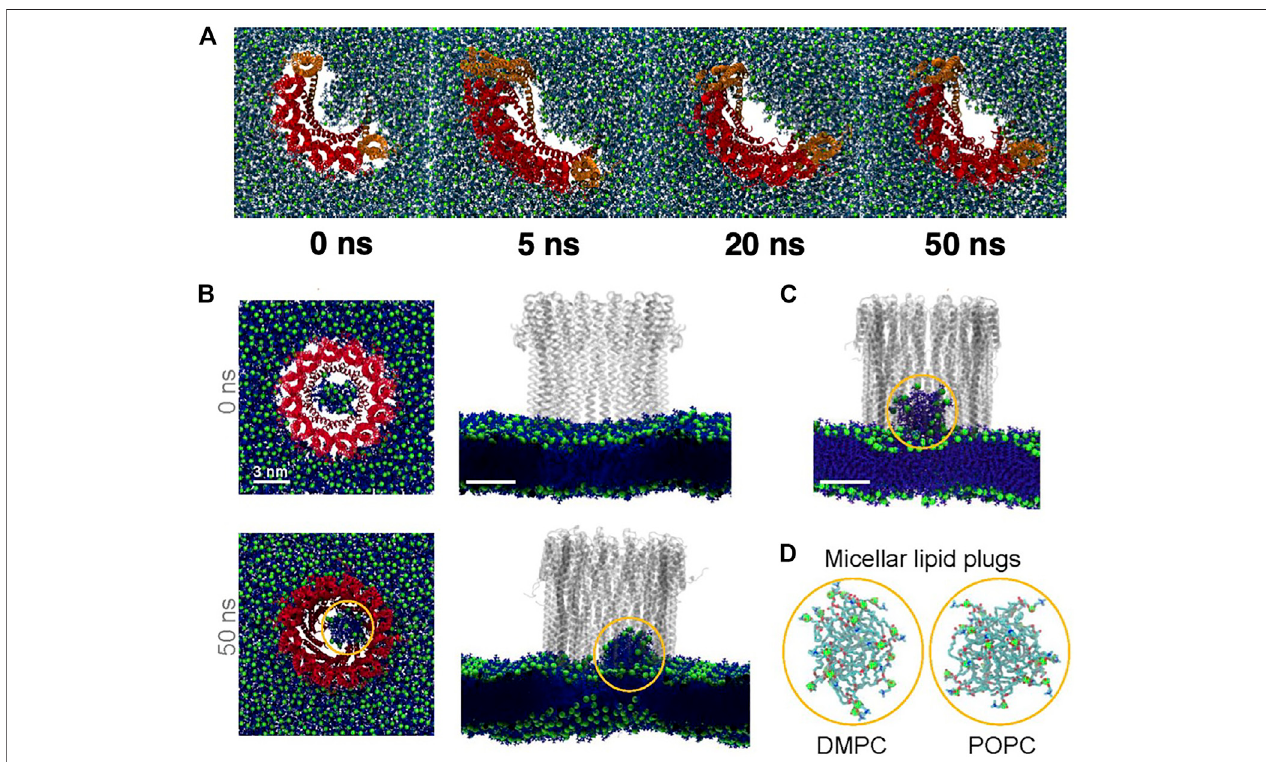
FIGURE 13 | Snapshots from all atom MD simulations of ClyA in lipid bilayers illustrating arc formation (A) and lipid ejection events (B – D) . (A) Dynamics of lipid evacuation and formation of a water channel (white) for a 7-mer membrane inserted ClyA arc. Formation of a micellar lipid plug in a dodecameric ClyA pore in a DMPC membrane. (B) topviews,andcorrespondingsideviews. (C) MicellarplugformationinaPOPCmembrane(50 ns).Inallcaseswatermoleculeshavenotbeenshownfor improved clarity. (D) Snapshots of the micellar plugs. (A) Reproduced with permission from Desikan et al. (2017), Copyright (2017), (B) Reproduced from Desikan et al.